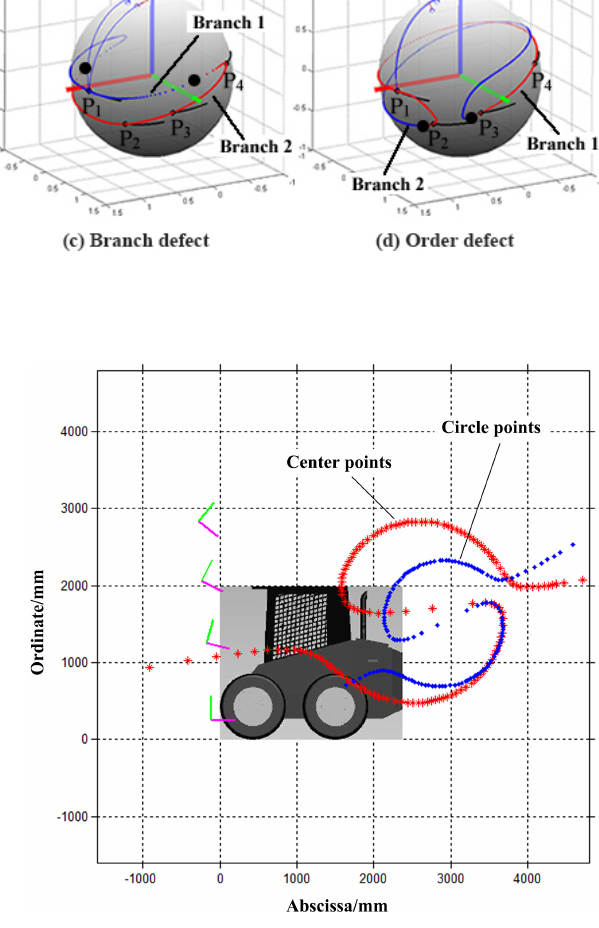
Figure 11. Center points and circle points generated by the program